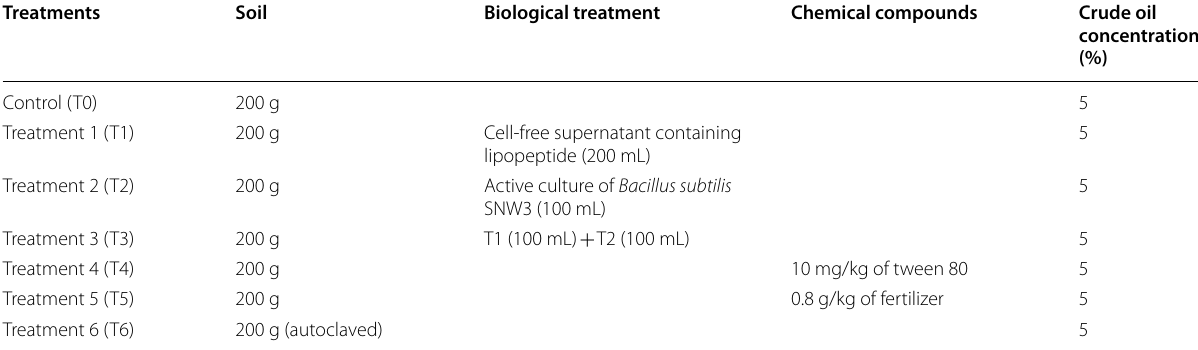
Table 2 Different design treatments for removal of crude oil from contaminated soil Treatments Soil Biological